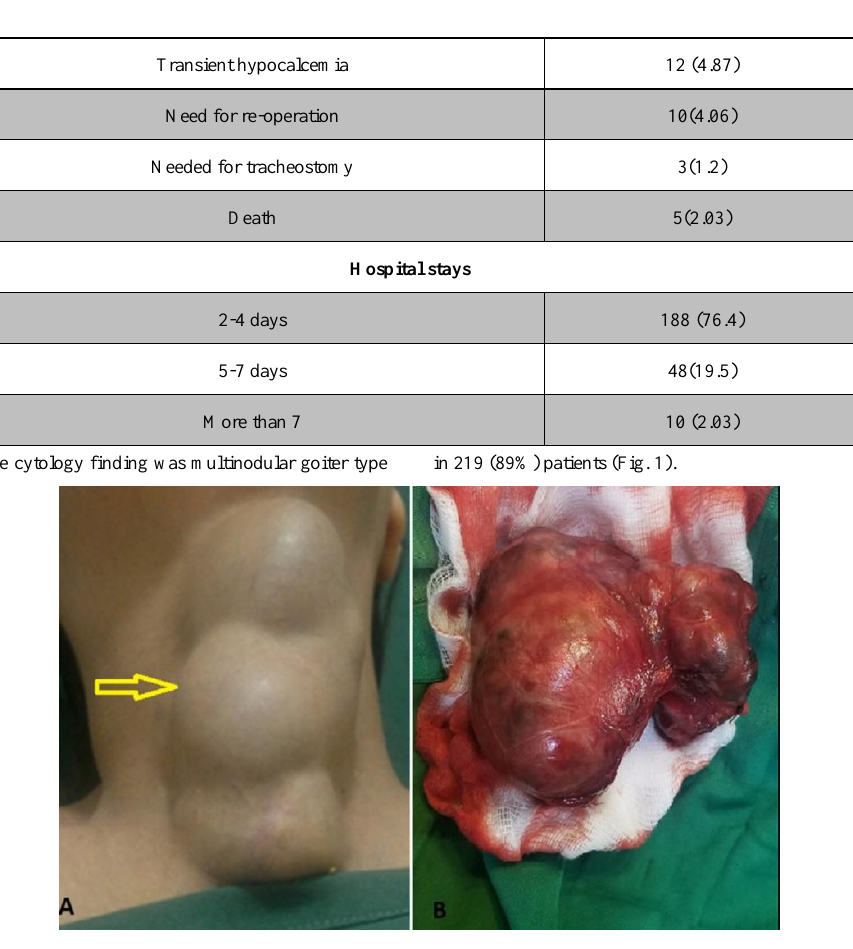
Fig. 1. Total thyroidectomy for multinodular goiter (A); show the mass (arrow). (B); intraoperative photo shows the resected mass.